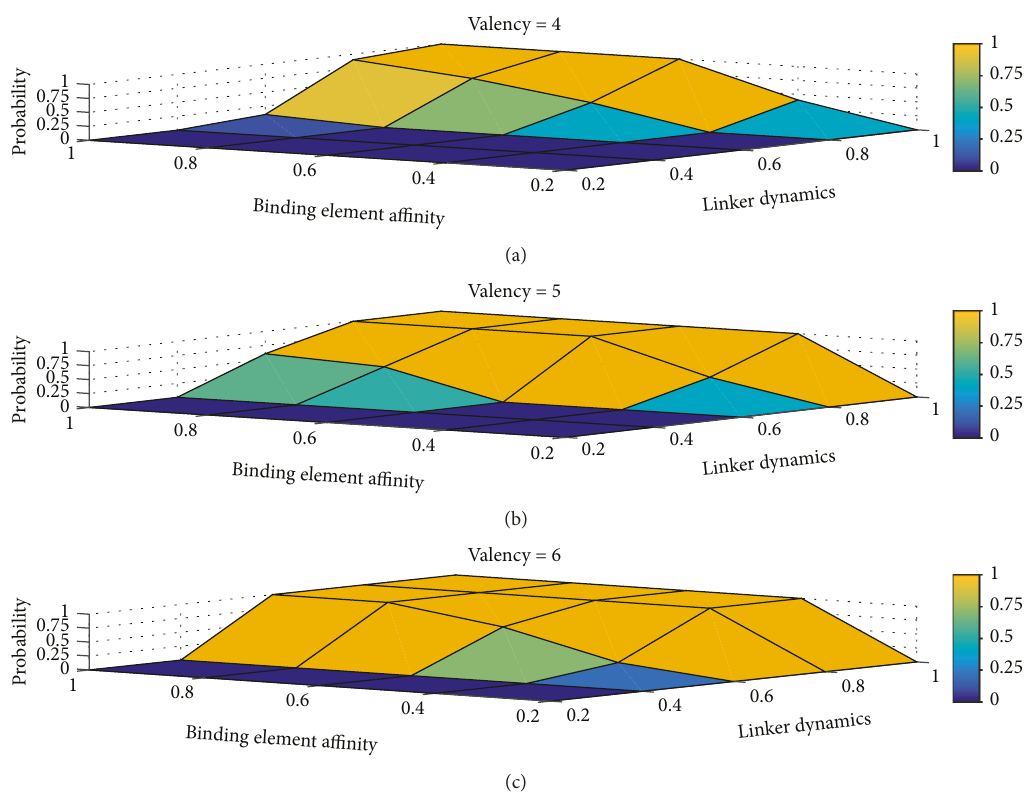
Figure 7: Probability of large polymers as a function of binding element a ffi nity and linker dynamics in the fuzzy binding model for valency n = 4 , n = 5 , and n = 6